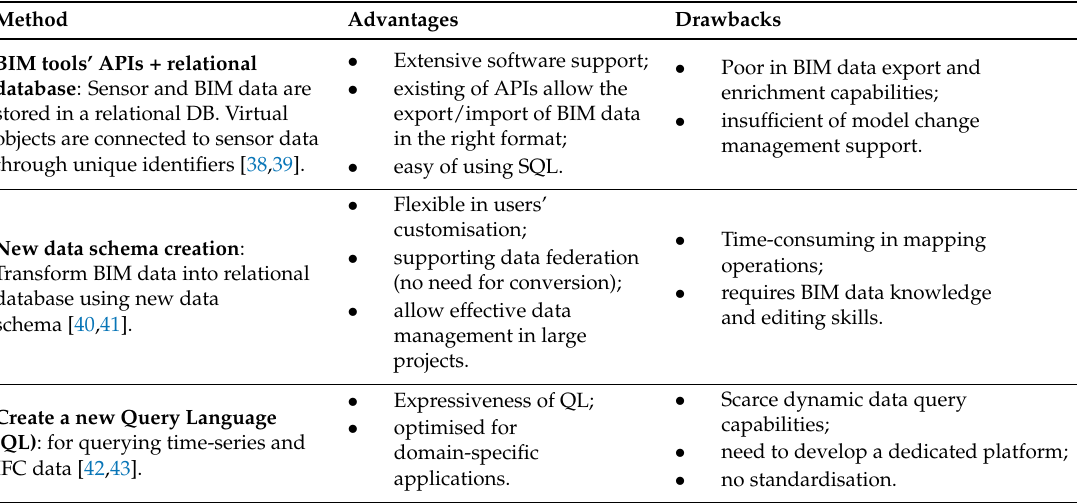
Table 1. BIM IoT data integration methods